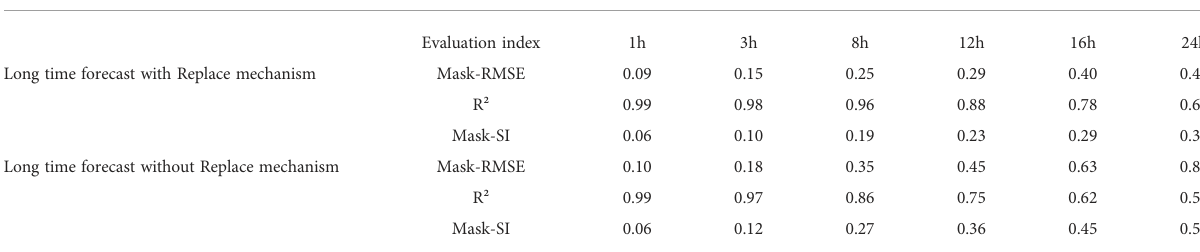
TABLE 2 The Evaluation index of the two model at different forecast